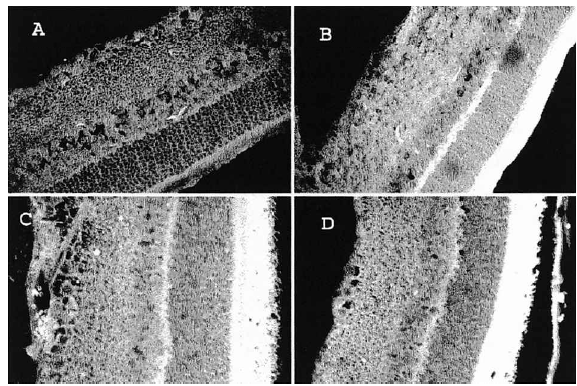
FIG. 4. Immunohistochemical localization of iNOS in intact retina. Retinal sections from normal and diabetic rats were incubated with the same anti-iNOS antibody used for the Western blot analysis. In control experiments retinal sections were only incubated with the secondary antibody. (A) retinal section from normal rats; (B) retinal section from Cs- A-treated normal rats; (C) retinal section from diabetic rats; (D) retinal section from Cs-A-treated diabetic rats. Magnifica- tion 20 ´